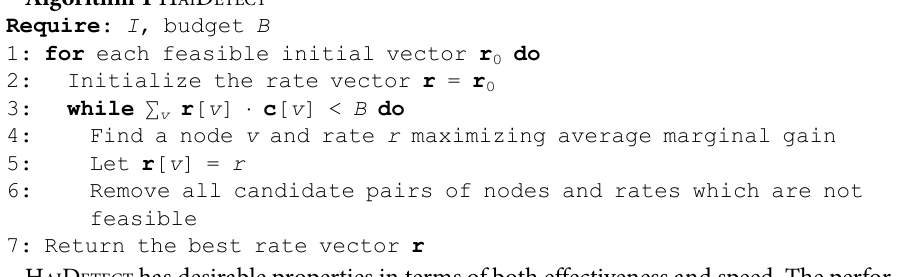
Algorithm 1 H AI D